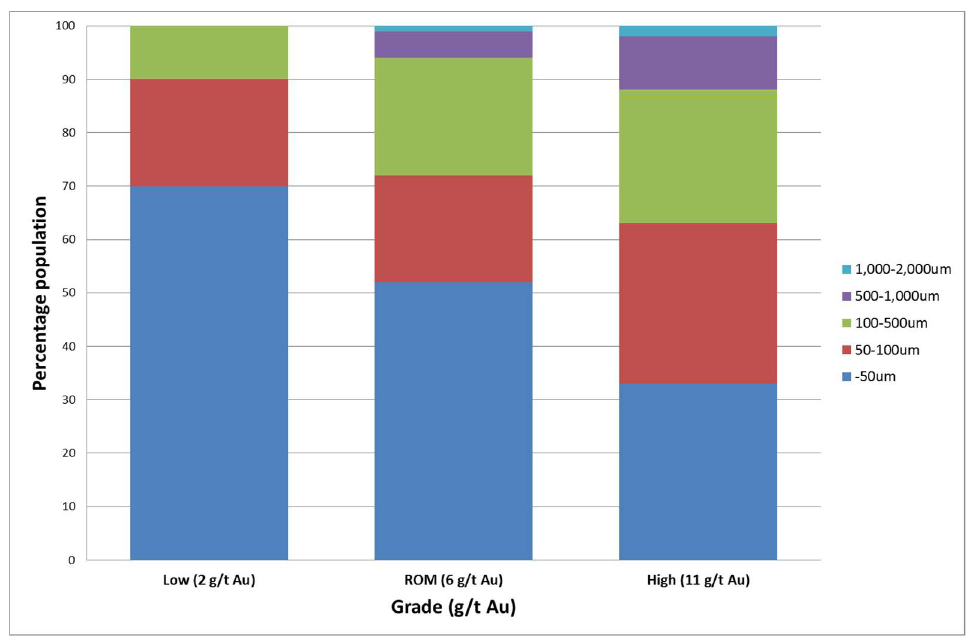
Figure 3. Percentage gold particle distribution by mass for SVZ grade domains.